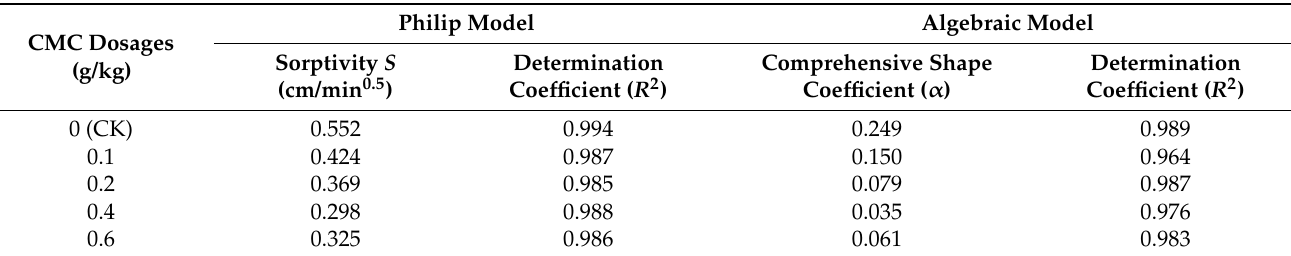
Table 2. Infiltration model parameters under different CMC